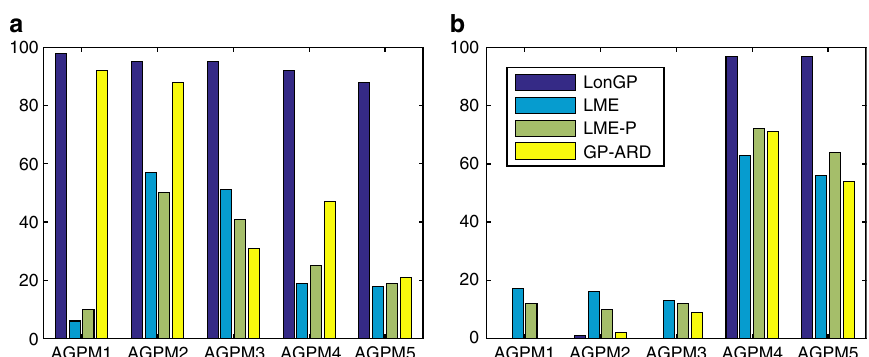
Fig. 3 Methods comparison. a Model selection accuracy. b Disease effect detection accuracy. As in Table 1, y -axis shows a the number of times the correct model is inferred as the fi nal model and b the number of times the diseaseAge covariate is included in the fi nal model out of 100 Monte Carlo simulations (Simulated data sets). Note that disease effect is only expected for AGPM4 and AGPM5 in panel b . AGPM stands for Additive GP Models. LME-P stands for Linear Mixed Effect model with Polynomial terms. GP-ARD stands for GP with Automatic Relevance